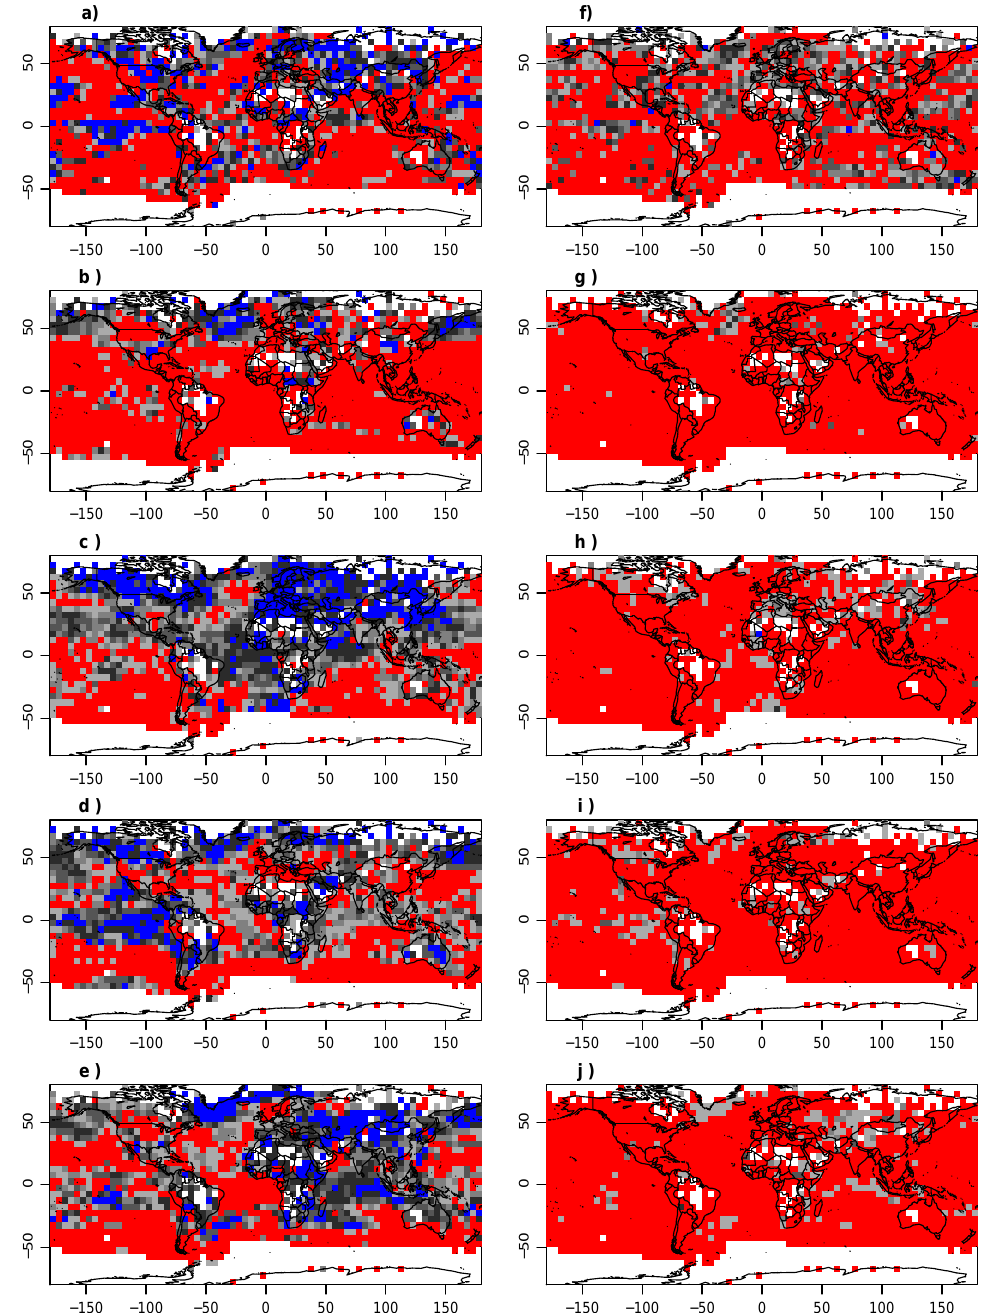
Fig. 10. Global assessment of the goodness-of-fit test for the decadal smooth data considering uncertainties in the target. Plotted are lower p values. In the left column: full χ 2 test, in the right column: maximum of p values for single deviation tests for bias and spread. Blue for smaller than 0.1, dark to light grey in steps of 0.2 for the range between 0.1 and 0.9, red for larger than 0.9. (a, f) full period and (b–e) and (g–j) for the first, second, third and last period of 250